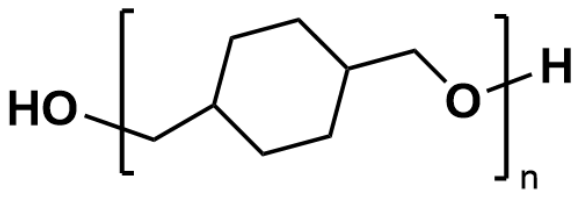
Figure 1. Chemical structure of PCDM.